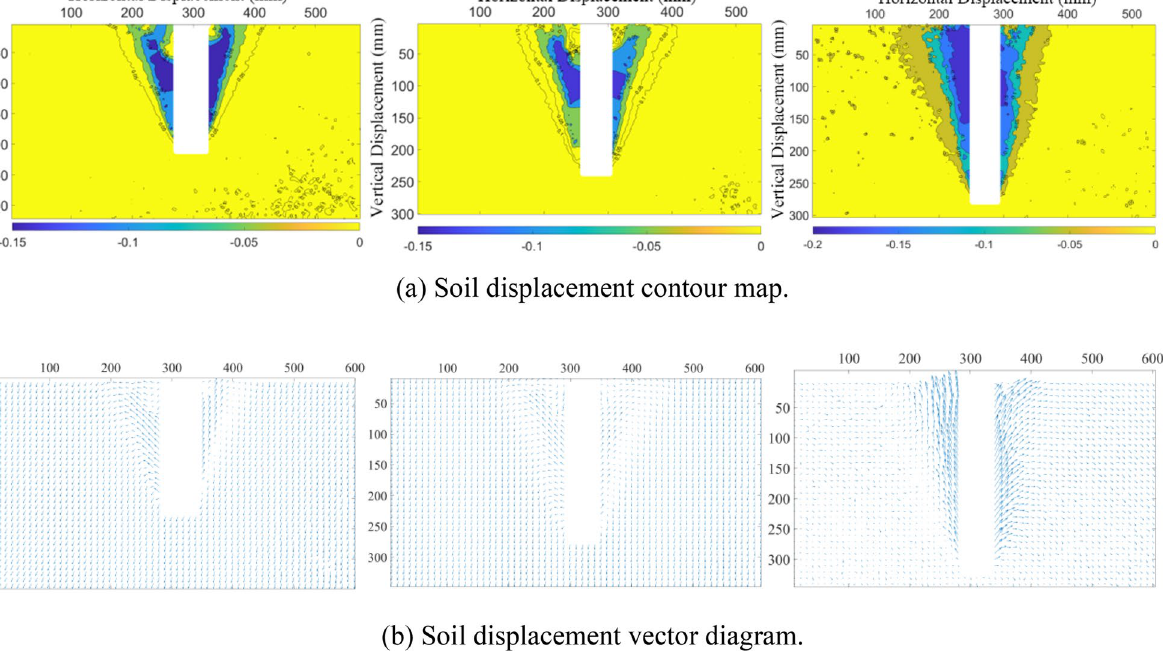
Figure 9. Soil displacement with different burial depths (200 mm, 250 mm, 300